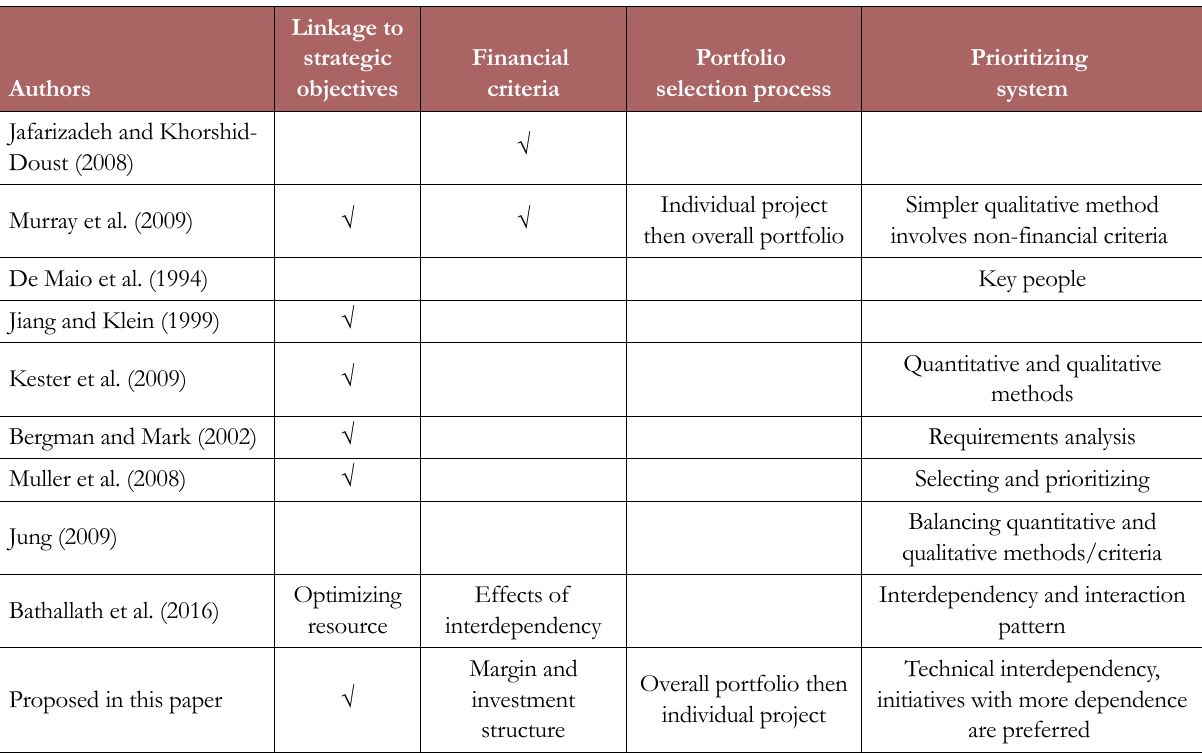
Table 1. Comparison of Various Portfolio Selection Techniques